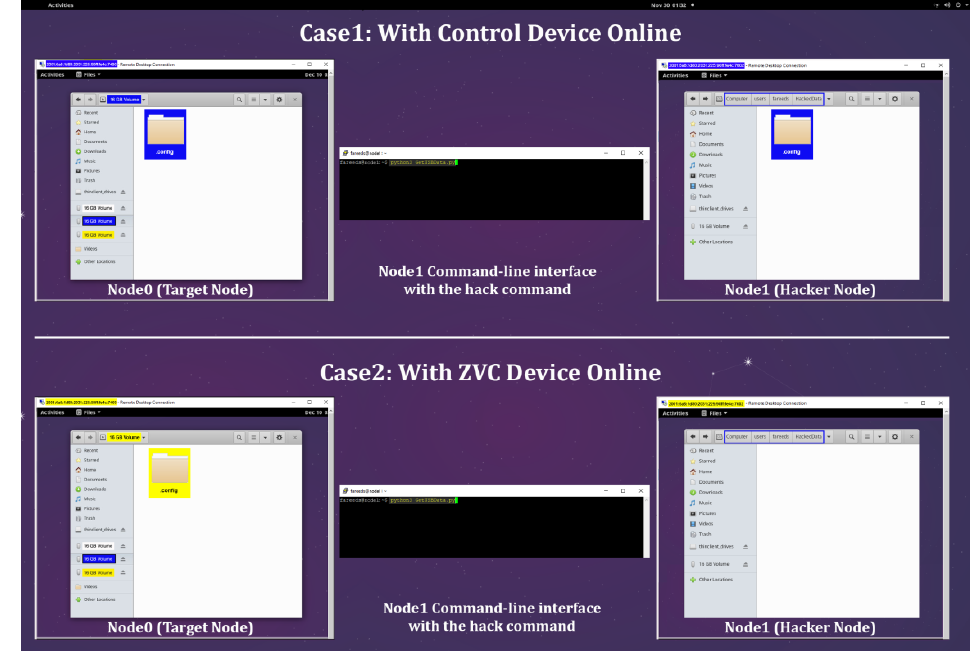
Figure 14. Screenshots of the command line interface showing the status of the .config file in the control and test devices .